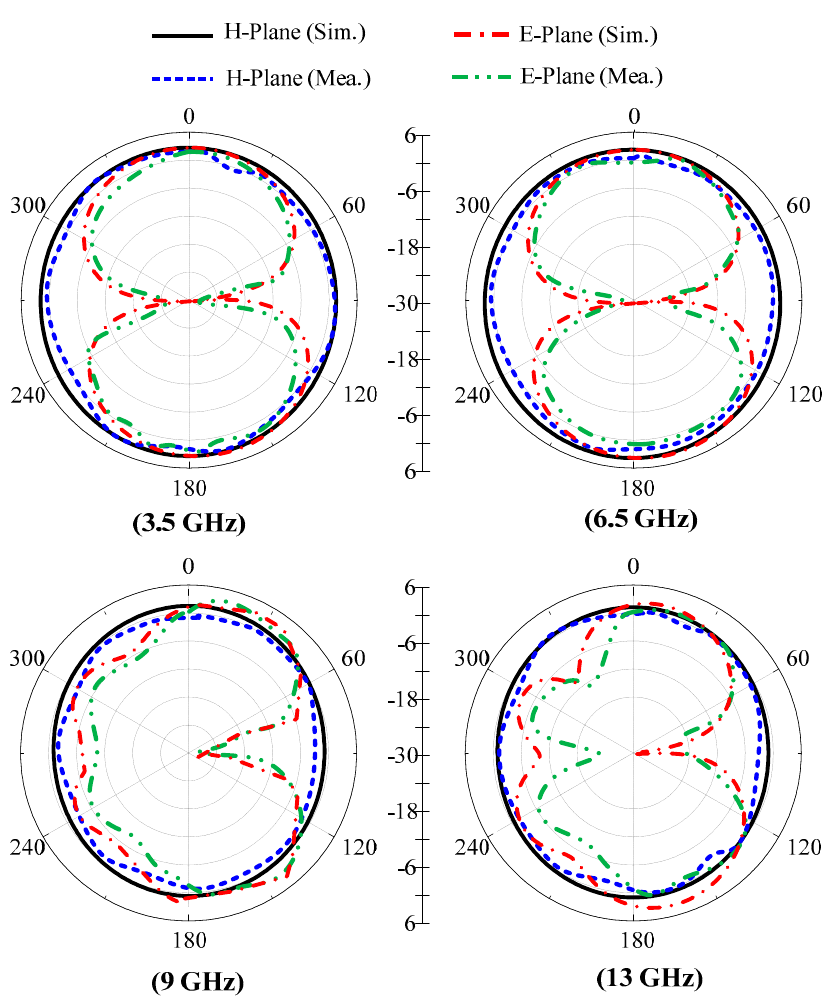
Figure 8. The radiation pa tt ern of proposed notch band extended UWB antenna at various frequen- cies.